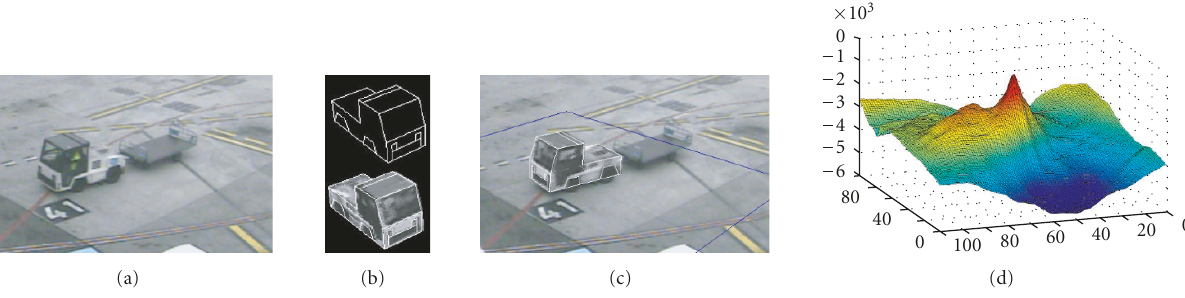
Figure 8: (a) Frame of sequence S21 showing a transporter vehicle. (b) Edge-based and appearance-based 3D model for the transporter vehicle. (c) The appearance model fitted to the vehicle, with the ground-plane ( x , y ) search area shown in blue. (d) x -, y -slice of the evaluation score surface in the ( x , y , θ ) search